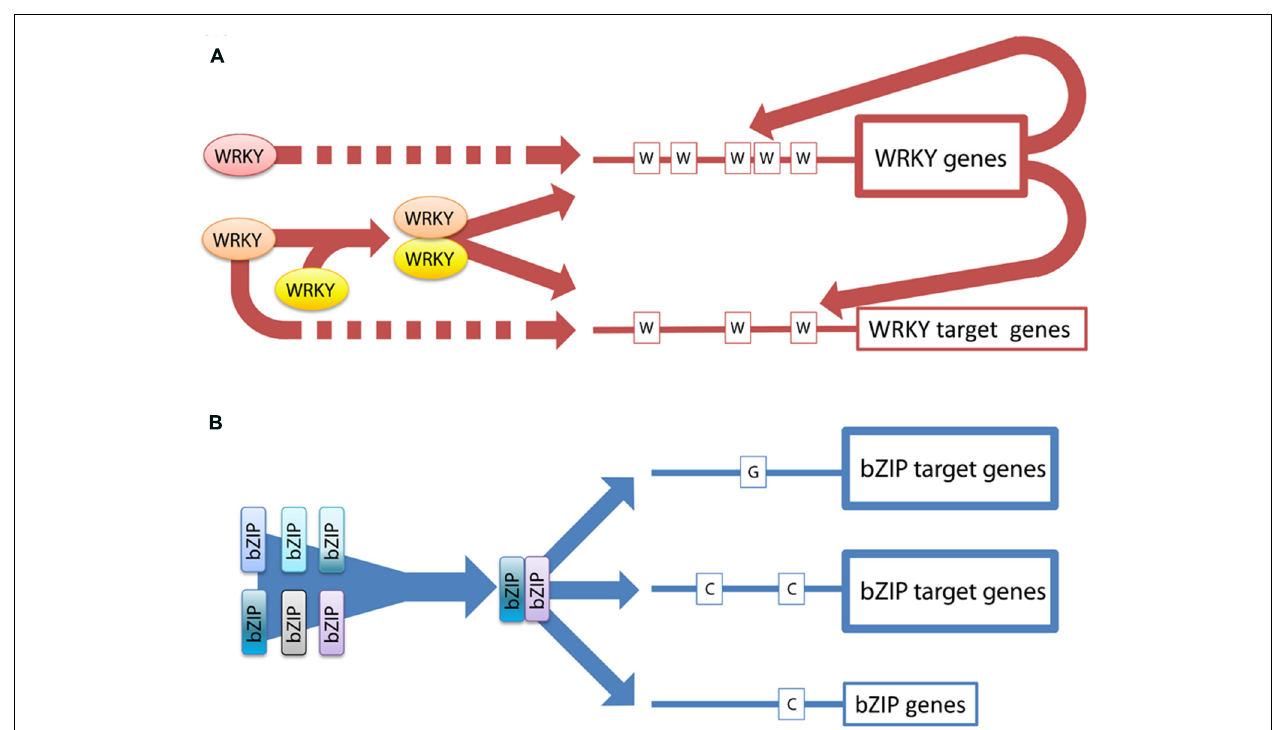
monomeric stage. In addition, WRKYs can form dimers and thereby increase the variability in regulating specific target genes. (B) In the bZIP family heterodimerization is extensively used to increase variability in target gene regulation. The activity of the bZIPs is regulated via specific dimerization which determines the target specificity. There are no indications for transcriptional